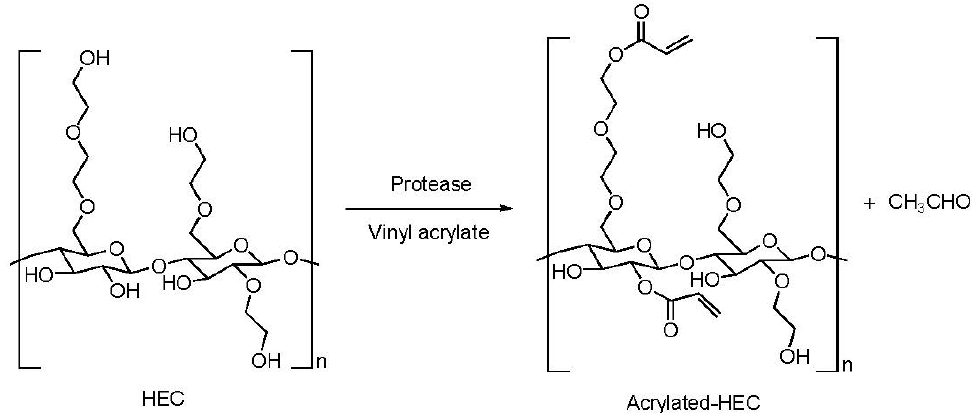
Figure 8. Reaction of vinyl acrylate with HEC, using protease as a